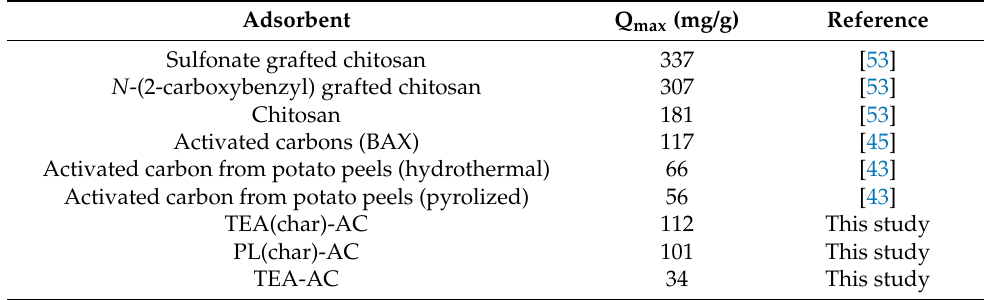
Table 4. Maximum adsorption capacities of different adsorbent materials for the removal of pramipex- ole from aqueous solutions.